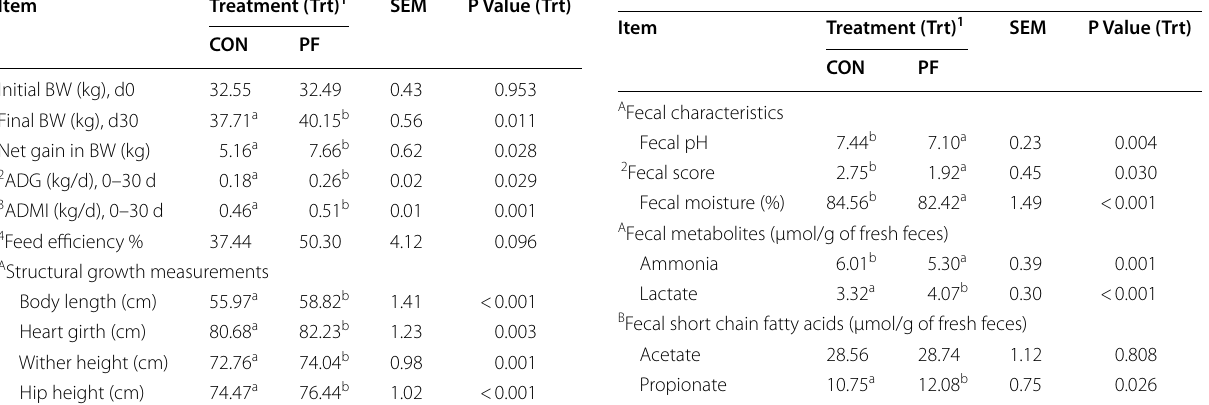
Table 3 Fecal characteristics, metabolites, and short chain fatty acids of Murrah buffalo calves supplemented with probiotic formulation (PF) or not